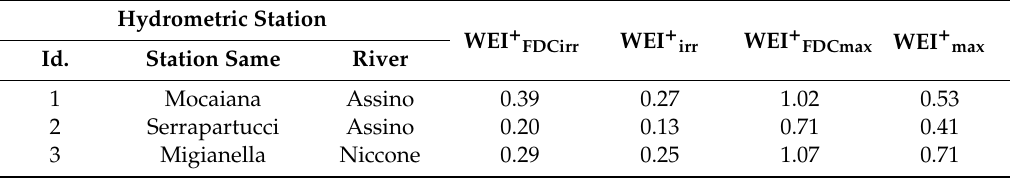
Table 2. Water Exploitation Index (WEI + ) in the studied